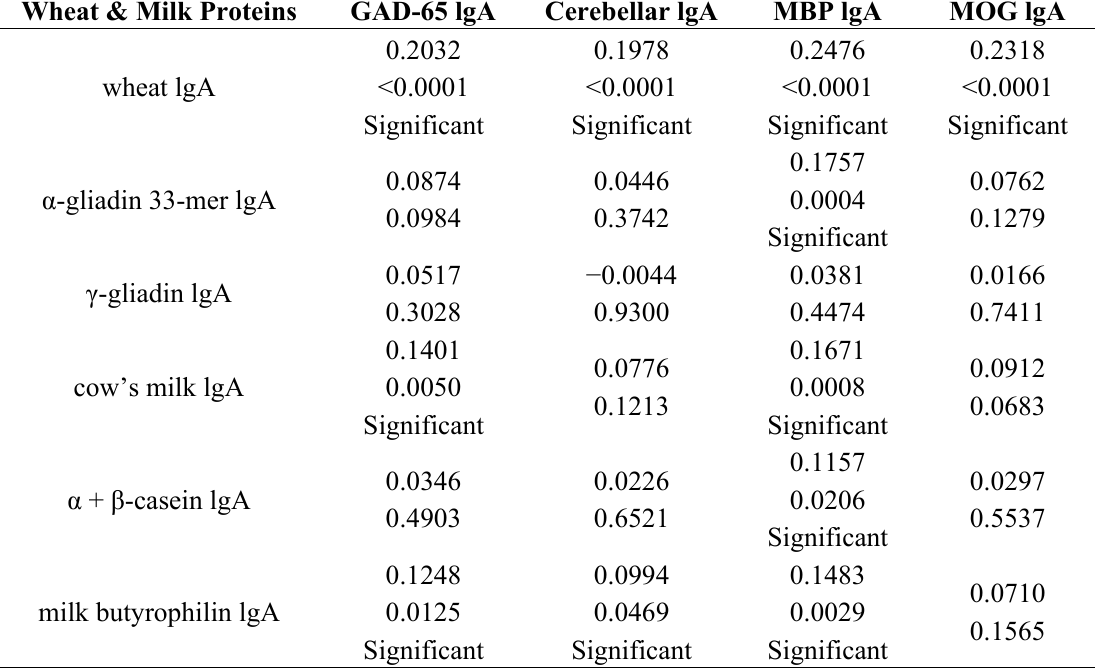
Table 2. Results of the simple linear regression between lgA isotypes of food proteins and the brain proteins. The first number in each cell presents corresponding Pearson’s correlation coefficient and the second number presents its p -value. Small p -value (less than 0.05) indicates statistical significance. Note that R 2 values of these regressions are the squares of the Pearson’s correlation coefficients.